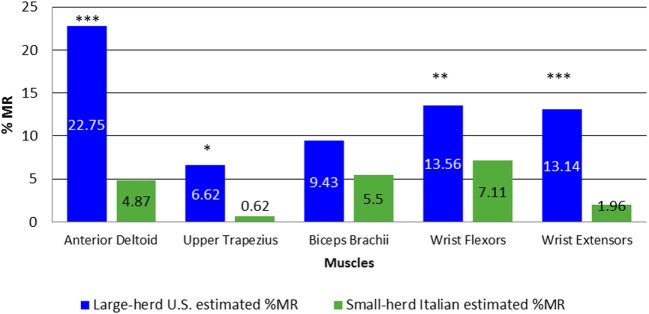
Simple main effects of dairy size × muscle interaction for %MR. *p = 0.004, **p = 0.002, and ***p < 0.001. %MR, percent muscular rest as percentage of total sEMG recording time.